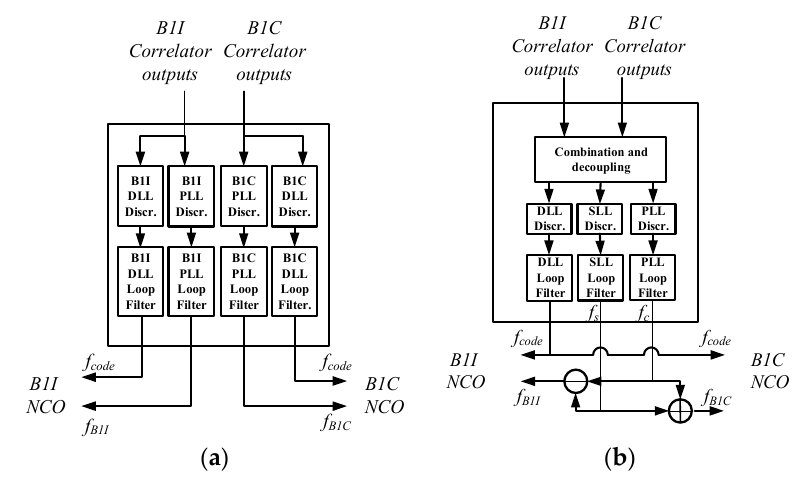
Figure 5. Two working modes of the processing unit. ( a ) Single-band mode; ( b ) Dual-band mode.